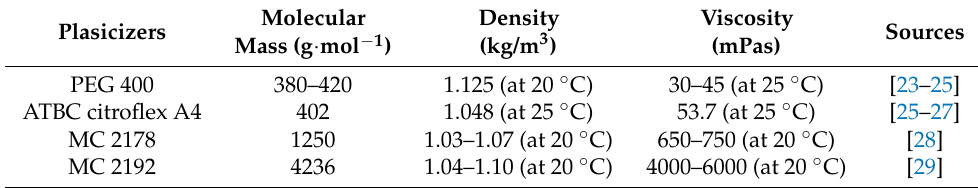
Table 1. Properties of